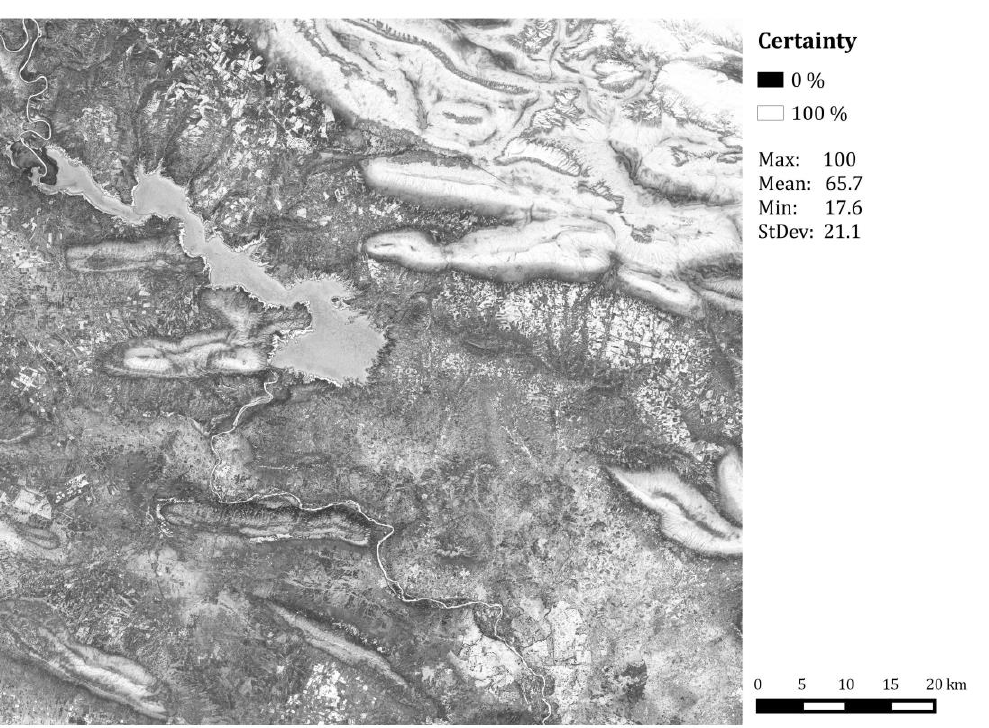
Figure 5. Final classification